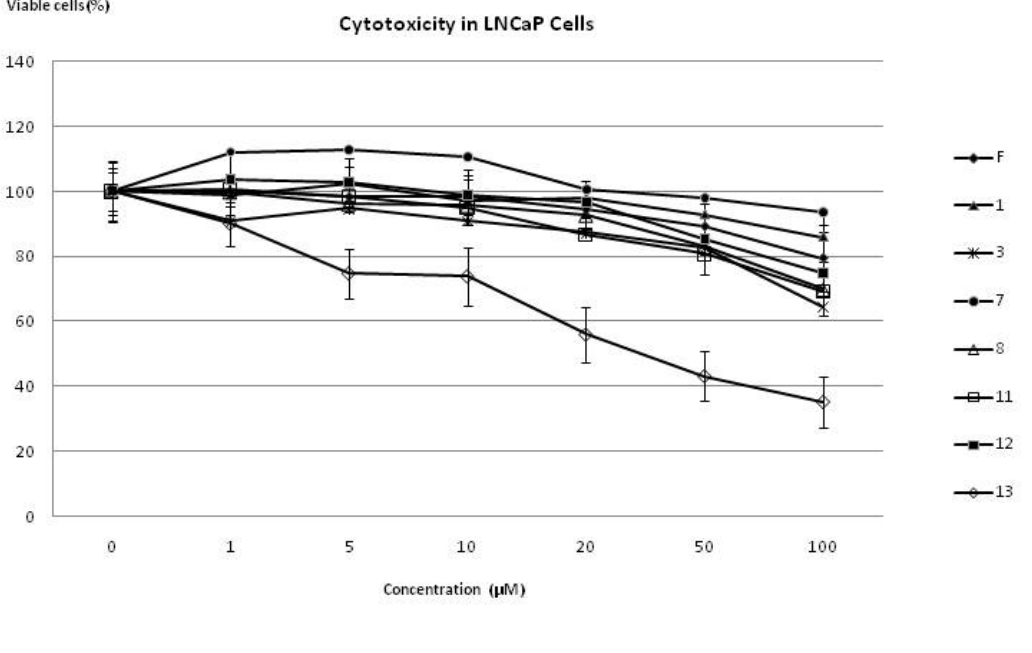
Figure 1. Cytotoxicity of F (finasteride) and 1 , 3 , 7 , 8 , 11 - 13 on LNCaP cells.